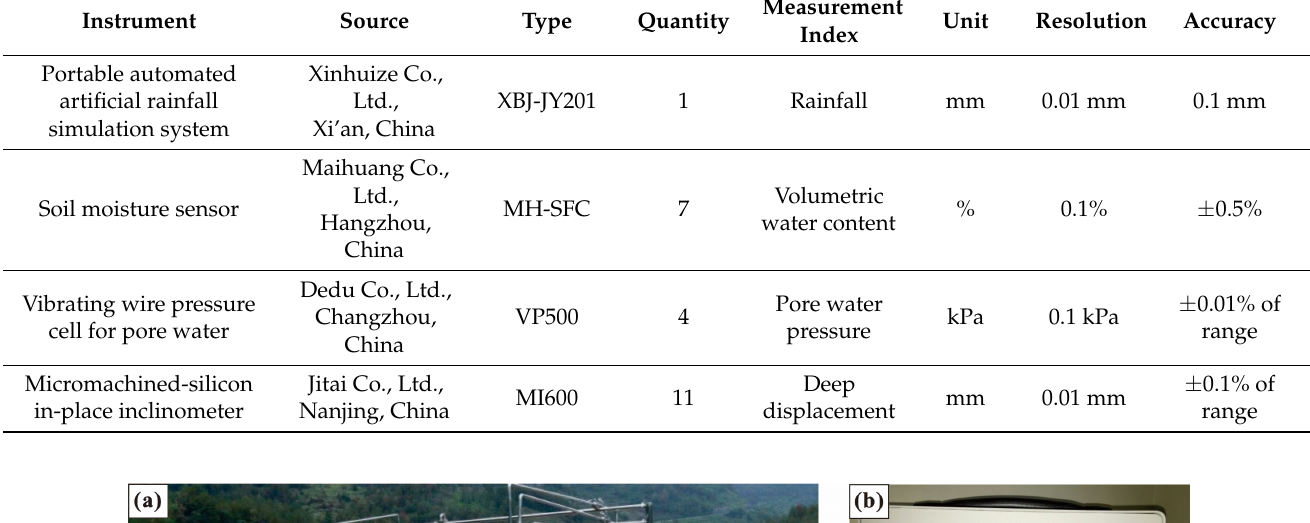
Table 1. Instruments used in the experiment.